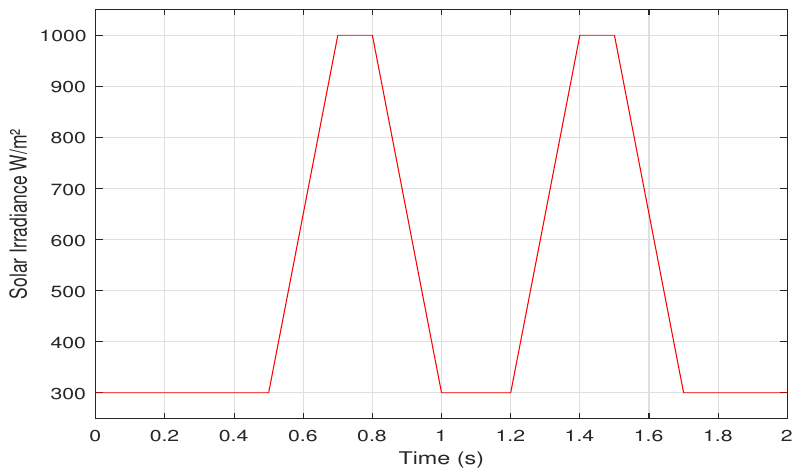
Figure 18. A dynamic solar irradiance change based on EN50530 standard.